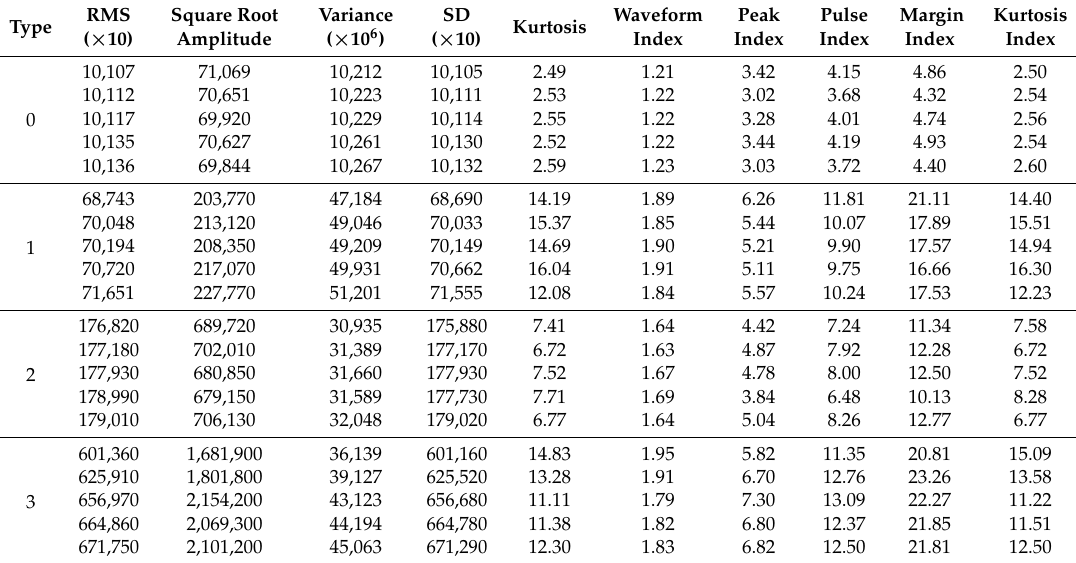
Table 2. The partial data of the time-domain indexes.